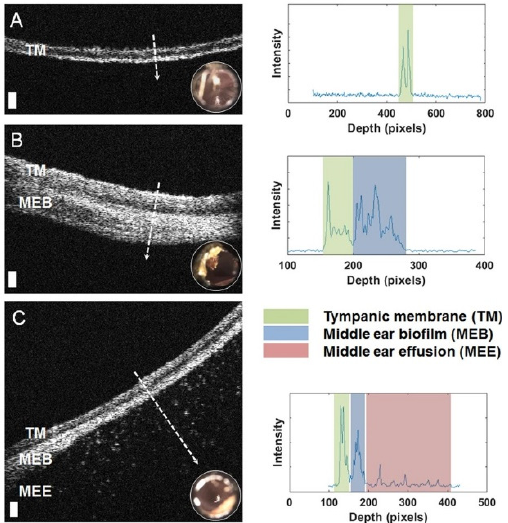
Figure 5. Left: Representative optical coherence tomography (OCT) cross-sectional (B-scan) images and A-line profiles. ( A ) OCT and digital otoscopy (inset) data from a normal ear. ( B ) Data from an ear with a middle ear biofilm (MEB). The A-line profile shows additional scattering behind the tympanic membrane (TM). ( C ) Subject with middle ear fluid (MEF) and an MEB. Right: The scattering profile shows three distinct regions in the scan. White dashed lines denote the location of the A-line scan within the OCT B-scan. Scale bars represent 100 micrometers in depth. Reprinted with permission from [178] Copyright © 2020, published by Springer Nature.